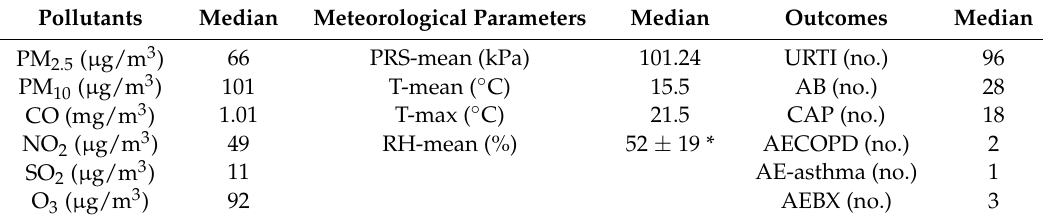
Table 1. Median daily values of pollutants, meteorological parameters, and outcomes.*